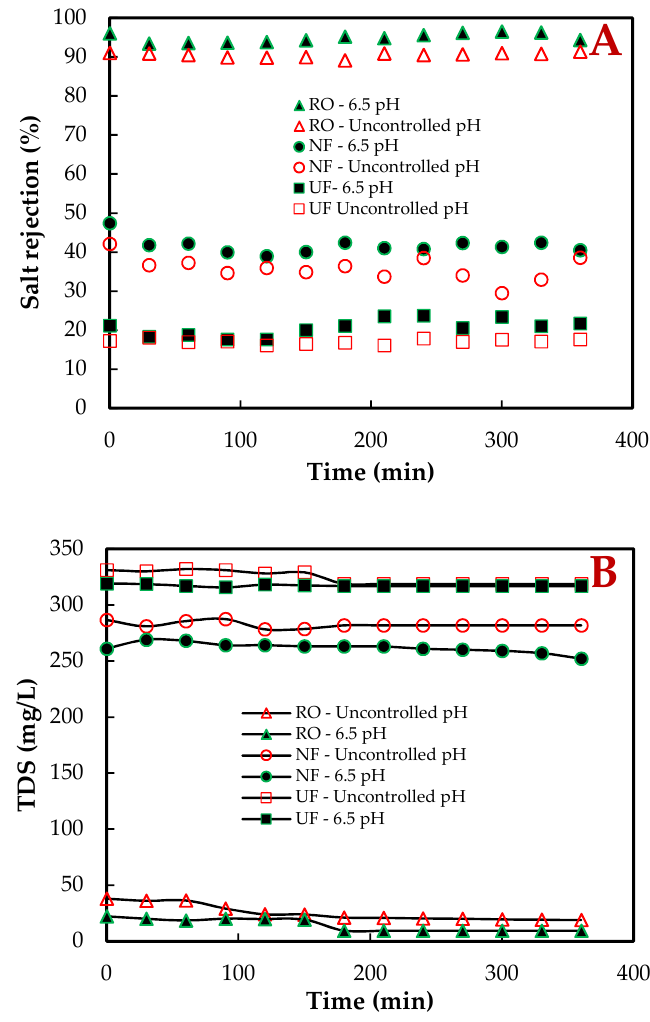
Figure 2. The measured effluents of the UF, NF, and RO membrane treatment at uncontrolled and controlled 6.5 pH pilot plant condition. Salt rejection ( A ) and TDS ( B ), all at a flux of 30 L · m − 2 h − 1 , and 75% recovery.